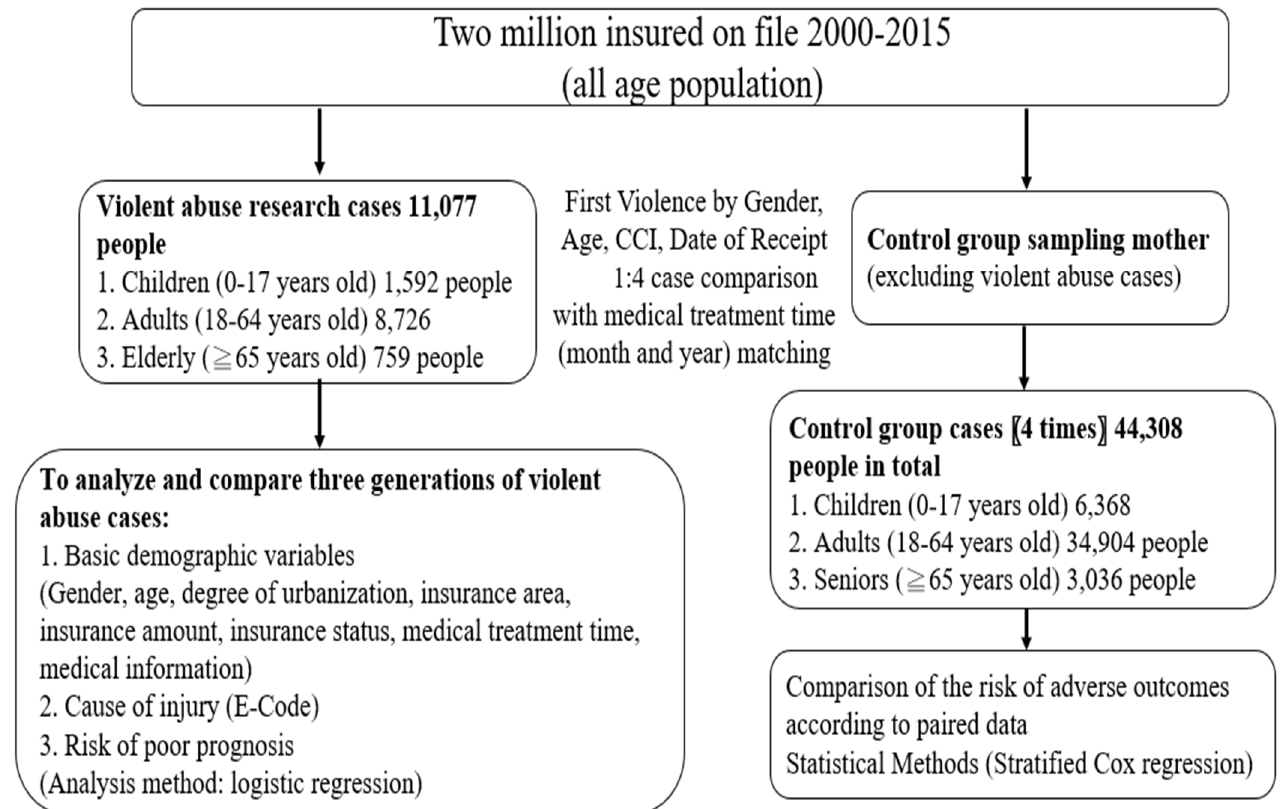
Figure 1. Research flowchart of poor prognosis in cases of violent abuse.